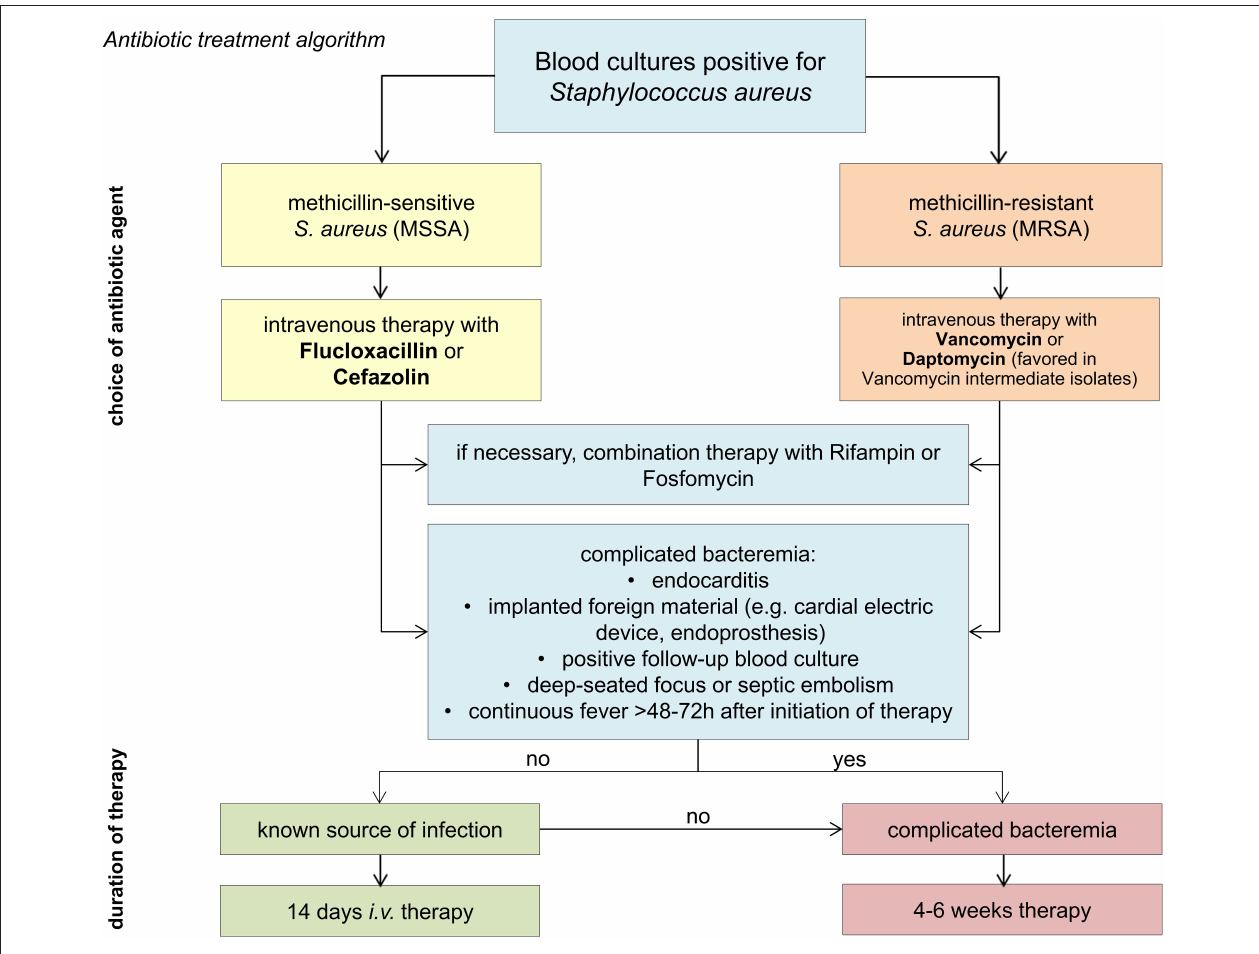
FIGURE 2 | Antibiotic treatment